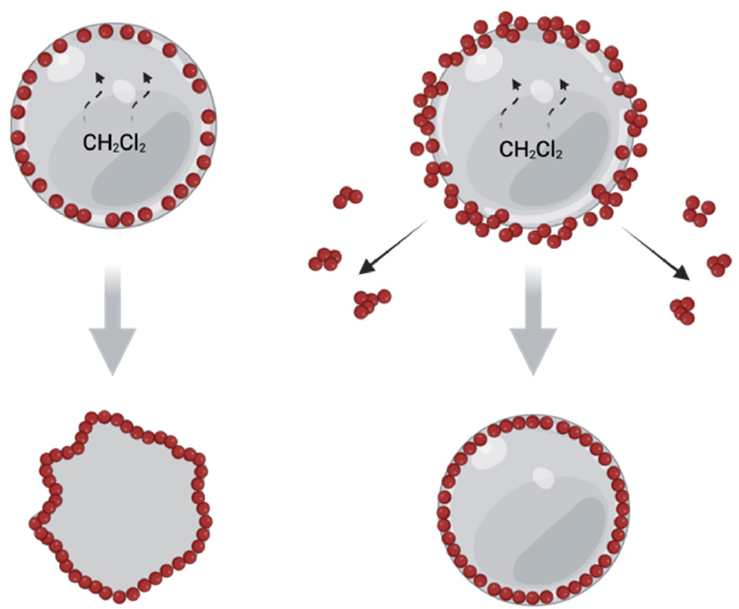
Figure 6. Schematic illustration of supposed reorganization of oi/water interface in the case of droplets stabilized with nHA water dispersions without ( a ) and with ( b ) preliminary US treatment. Created with BioRender.com (accessed on 29 September 2022).